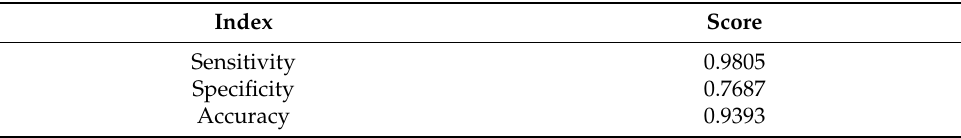
Table 7. Classification performance of normal and MI classes in Setting 2.